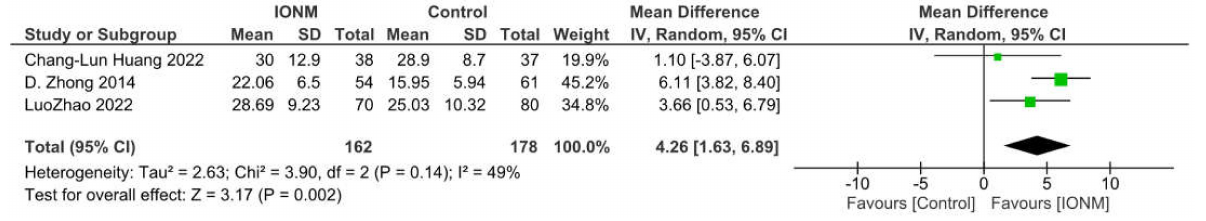
Figure 3. Forest plot of IONM for number of mediastinal LN dissected. Abbreviations: IONM— intraoperative neuromonitoring.